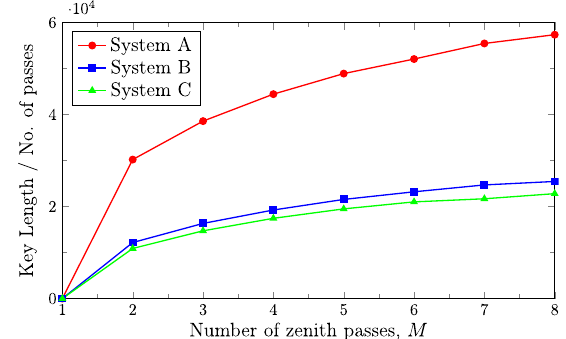
Fig. 6 Per-pass SKL vs Number of combined overpasses. Secret key is generated from combined multiple overpass data. Zenith overpasses with θ min ¼ 10 (cid:2) . System parameter sets ; p ; QBER = {45.7 dB, 10 − 7 , 0.5%}, B = {44.8 dB, 10 − 7 , 1%}, f η sys I g : A ec = 5 × 10 − 7 and QBER = loss I and C = {40.5 dB, 5 × 10 − 7 , 1%}. Fig. 5 SKL vs ground track off-set. p ec